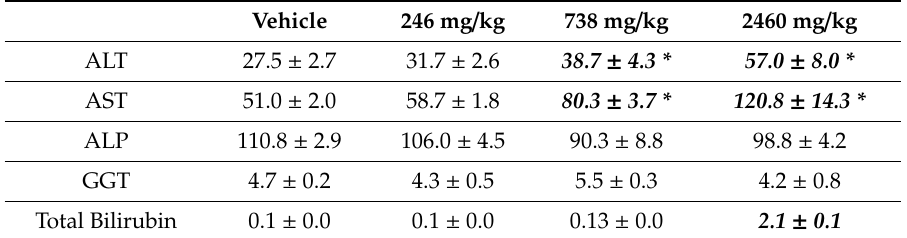
Table 1. Clinical chemistry parameters 24 h after dosing with CBD oil. Cells in bold italics are significantlydi ff erentfromvehicle(One-WayANOVA,indicatedby*, orKruskal-Walliswithappropriate post-hoc test). Data presented as mean ± SEM ( n = 6 /